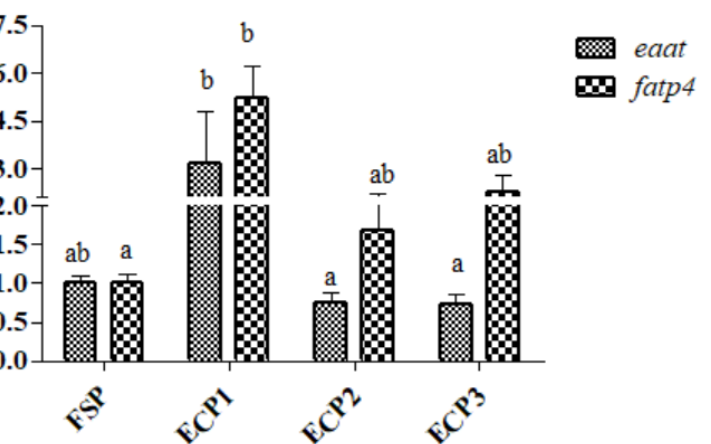
Figure 4. Effect of fish soluble pulp and enzymatic chicken pulp on the expression of eaat and fatp4 on mRNA gene in the hepatopancreas of L. vannamei . eaat- excitatory amino acid transporter, fatp4 - fatty acid transport protein 4. Means without superscripts or with the same superscripts do not differ significantly ( p > 0.05), while those with different superscripts differ significantly ( p < 0.05).